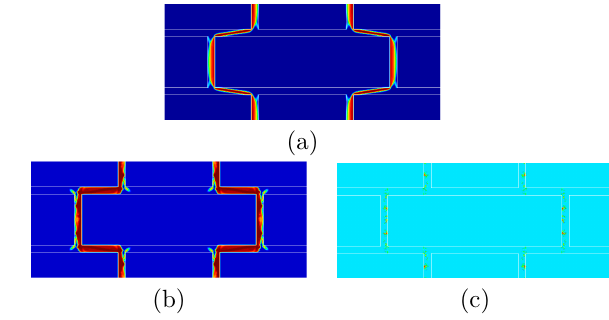
Figure 10. Damage pattern due to E